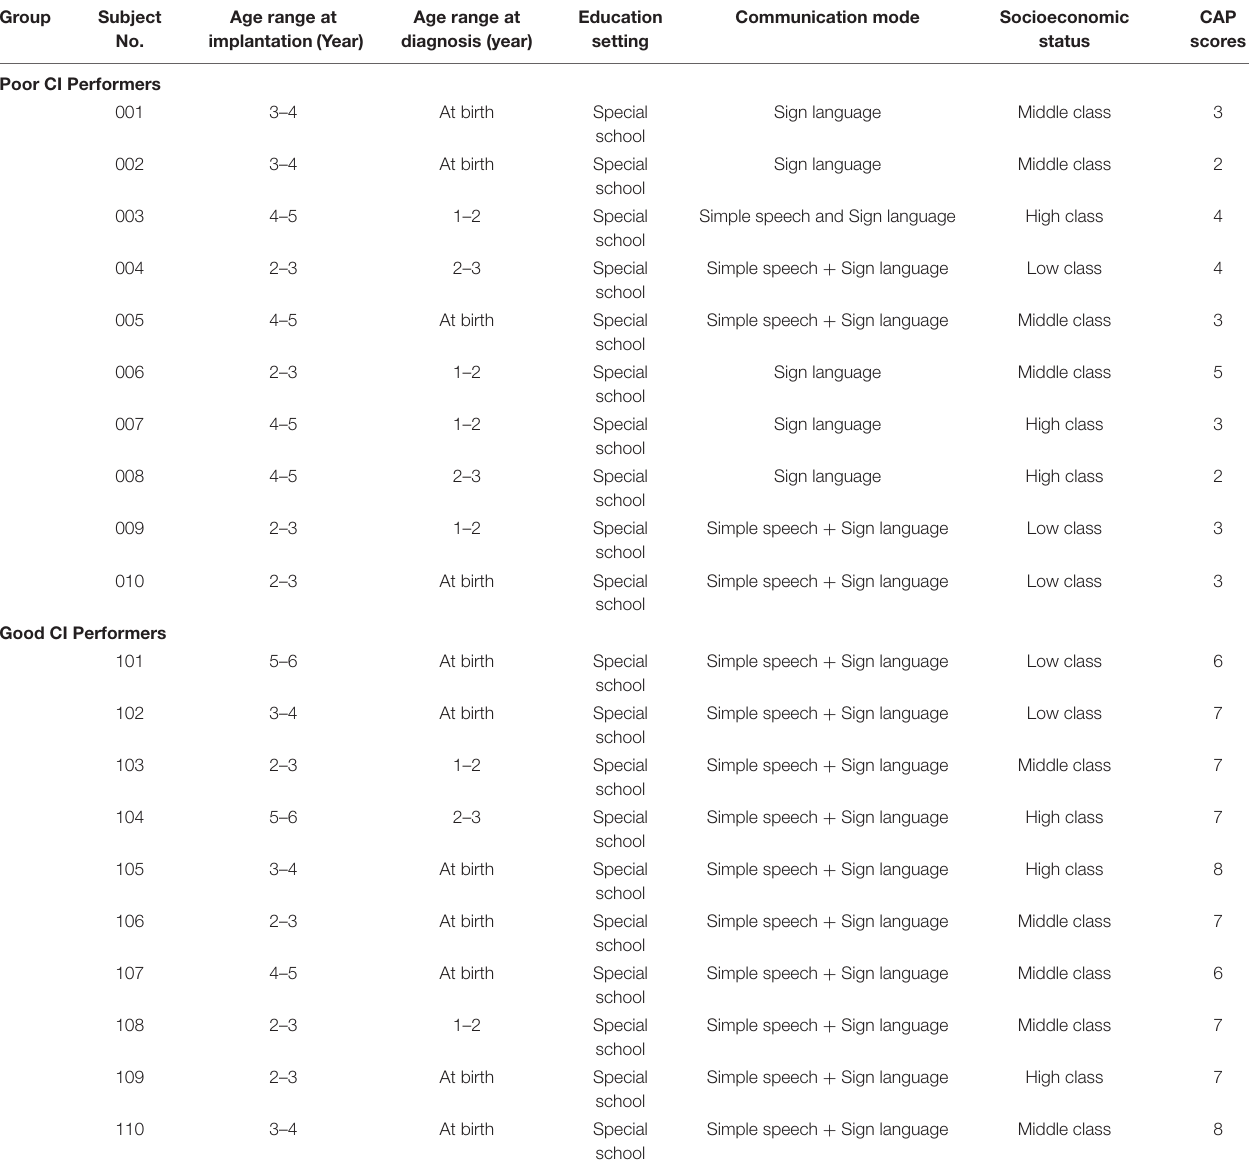
TABLE 1 | Detailed demographic information of the CI